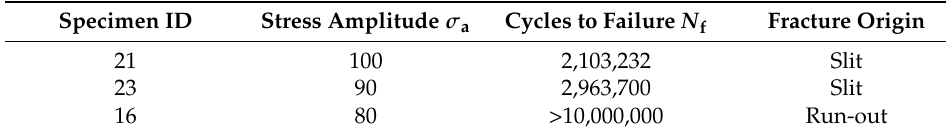
Table A2. Fatigue test results for WS1.0.